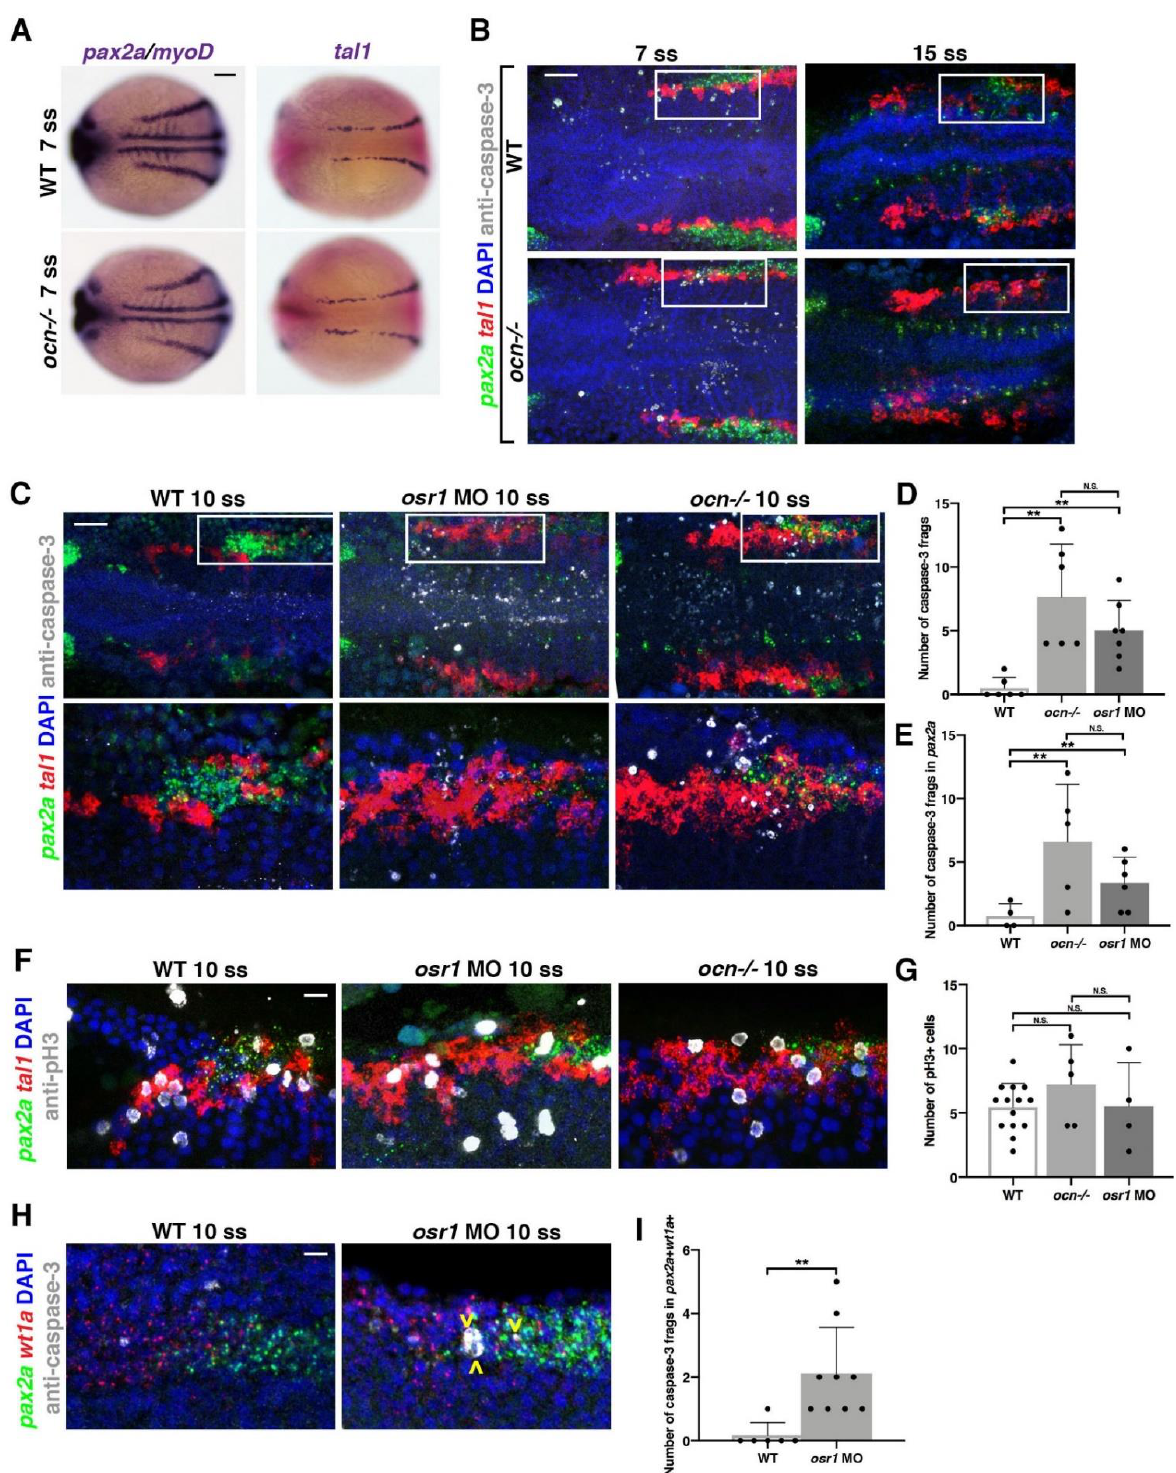
Figure 2. osr1 is required to maintain and promote kidney development at the expense of heman- gioblasts. ( A ) Although pax2a is restricted in 15 ss mutants, at 7 ss, ocn − / − embryos had a pax2a domain that appeared to occupy the same domain as WT siblings. Similarly, the hemangioblast marker tal1 appeared mostly WT in ocn − / − at 7 ss. Scale bar is 50 µ m ( B ) FISH with probes for pax2a (green) and tal1 (red) and ICC using anti-caspase-3 (white) to mark apoptotic cells was conducted at 7 ss and 15 ss. The number of fragments in the combined pax2a and tal1 fields from somites 1–5